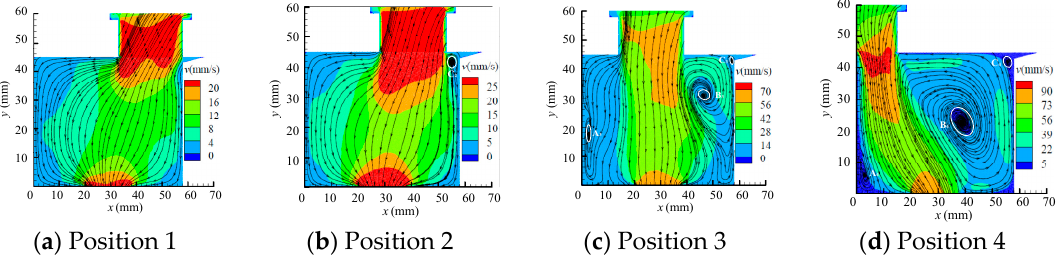
Figure 10. Velocity contours and streamlines with a piston moving speed of 8.3 mm/s.